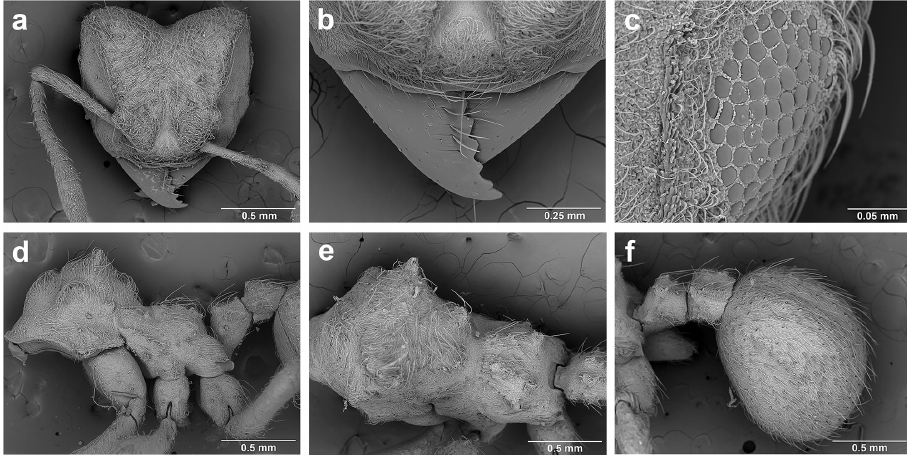
Figure 24. S. bondari worker (USNMENT01125813), SEM images. a Head, full-face view b mandibles c eye d mesosoma, lateral view e mesosoma, dorsal view f metasoma, dorsolateral view.